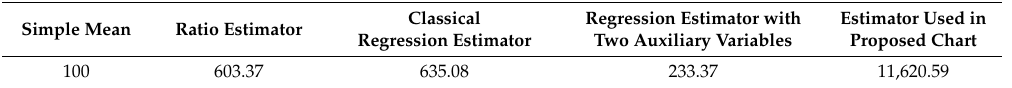
Table 1. Percentage relative efficiency of